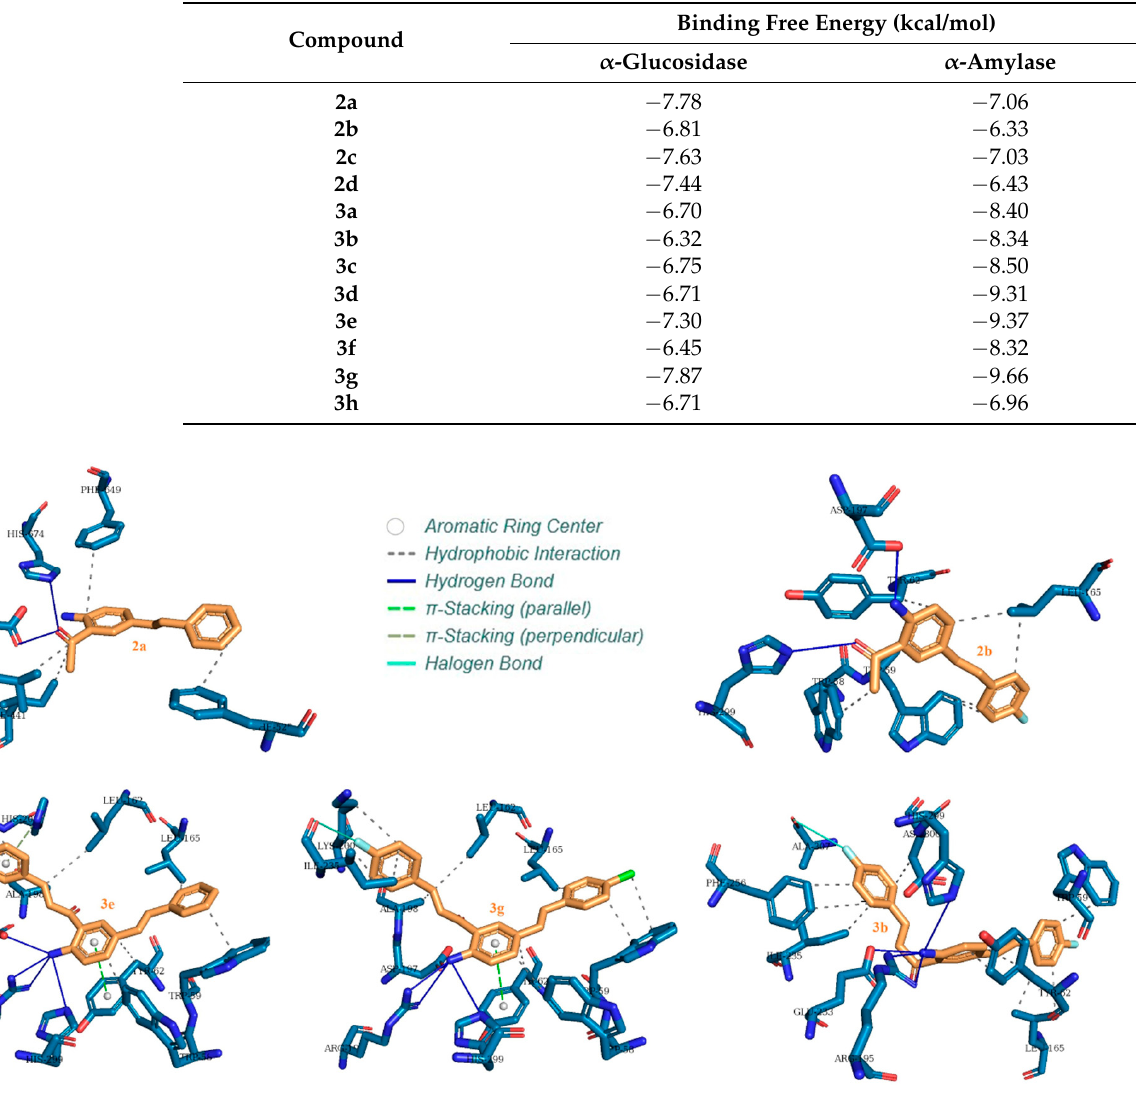
Table 3. The predicted binding free energy values of 2a – d and 3a – h obtained from docking simulation of the test compounds against α -glucosidase and α -amylase.